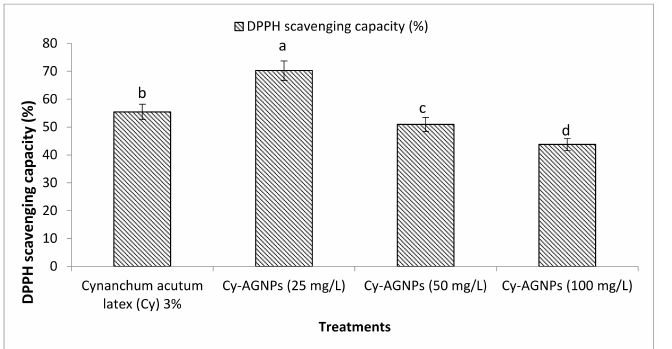
Figure 7. Antioxidant activity of C. acutum crude latex (3%) and its different AgNP concentrations using DPPH. Bars with different letters indicate significant differences between treatments at p ≤ 0.05. Data are expressed as the mean of three replicates ±